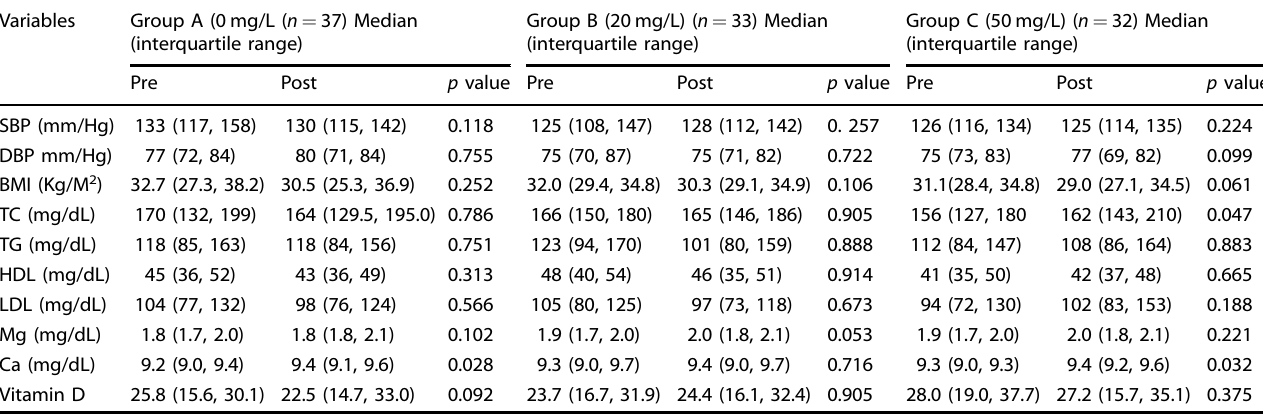
Table 4. Effect of different doses of magnesium chloride added to the desalinated water on clinical and other laboratory parameters. Variables Group A (0 mg/L ( n = 37) Median (interquartile